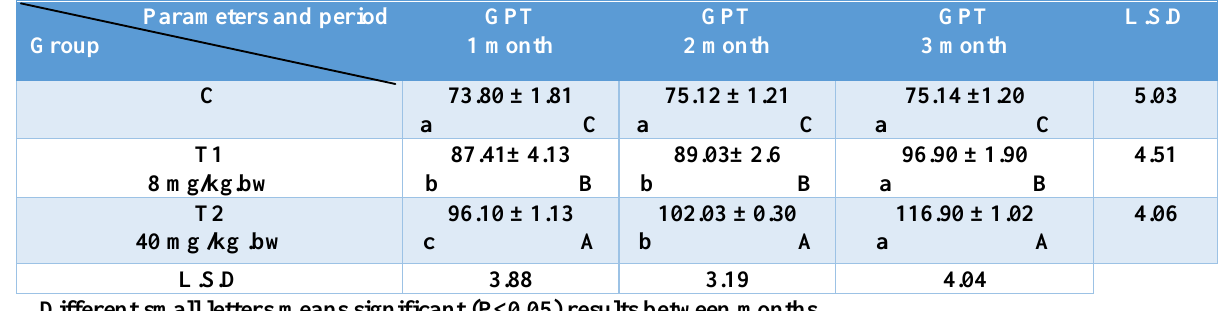
Table, 10: Values of GPT ( U/ L) in serum of rats treated with different doses of CuSO4.5H2O